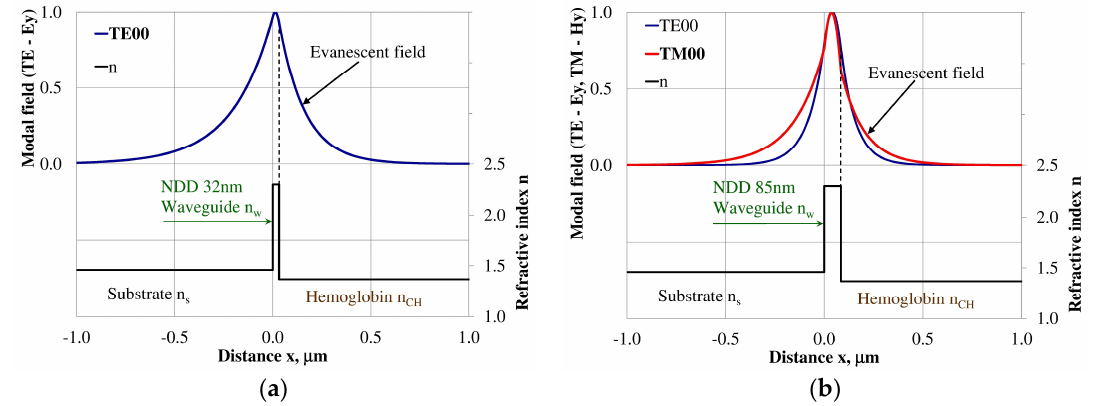
Figure 5. Modal field distribution in the single-mode NDD-based waveguide: ( a ) TE00 for maximum dN eff / dn cH , and ( b ) TM00 for maximum dN eff / dn cH .